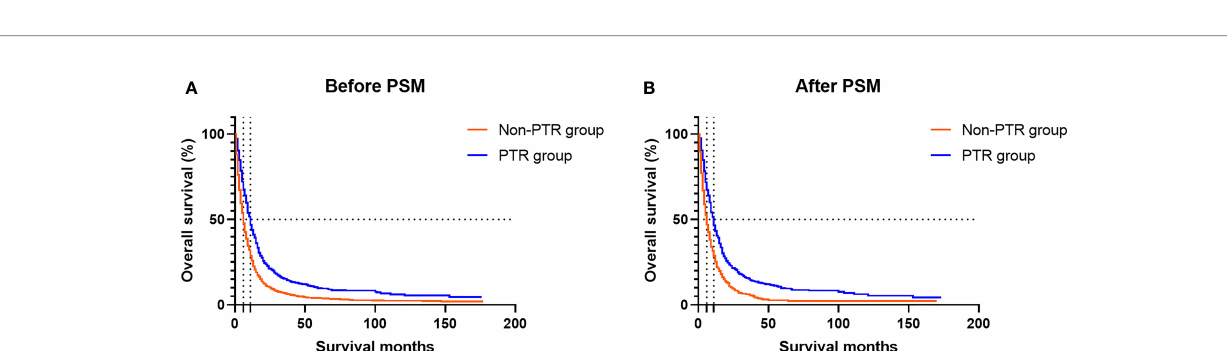
FIGURE 3 | Kaplan – Meier plots show the overall survival of mBC patients according to the group. (A) Before PSM, the PTR group had a better prognosis than the non-PTR group (11.0 vs. 6.0 months; p < 0.001). (B) After PSM, we still observed that those who received PTR had longer median OS (11.0 vs. 6.0 months; p < 0.001) than those in the non-PTR group. mBC, metastatic bladder cancer; PSM, propensity score matching; PTR, primary tumor resection; OS, overall survival.